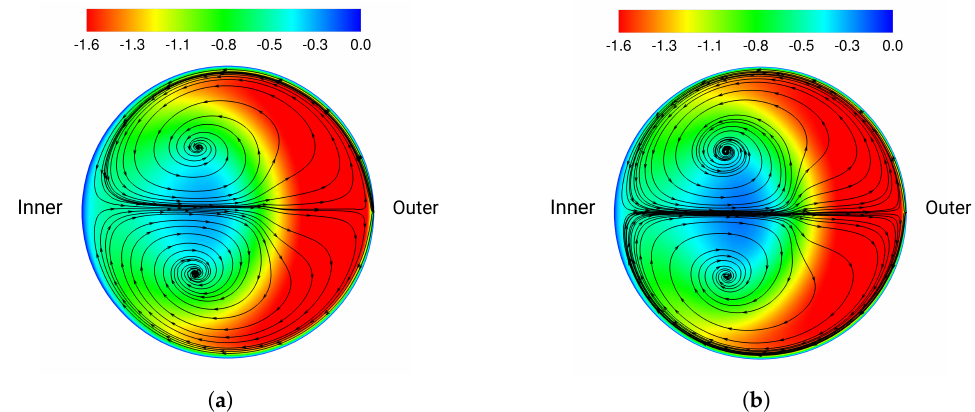
Figure 10. Time-averaged dimensionless streamwise velocity (cid:104) v (cid:105) / U b and streamlines of the 90 ◦ cases in the x - z plane at y / D = − 1.5. ( a ) Re L . ( b ) Re H